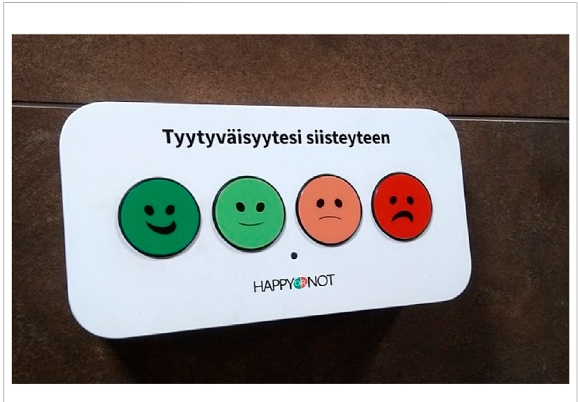
FIGURE 1 An example of the guerrilla solution design by